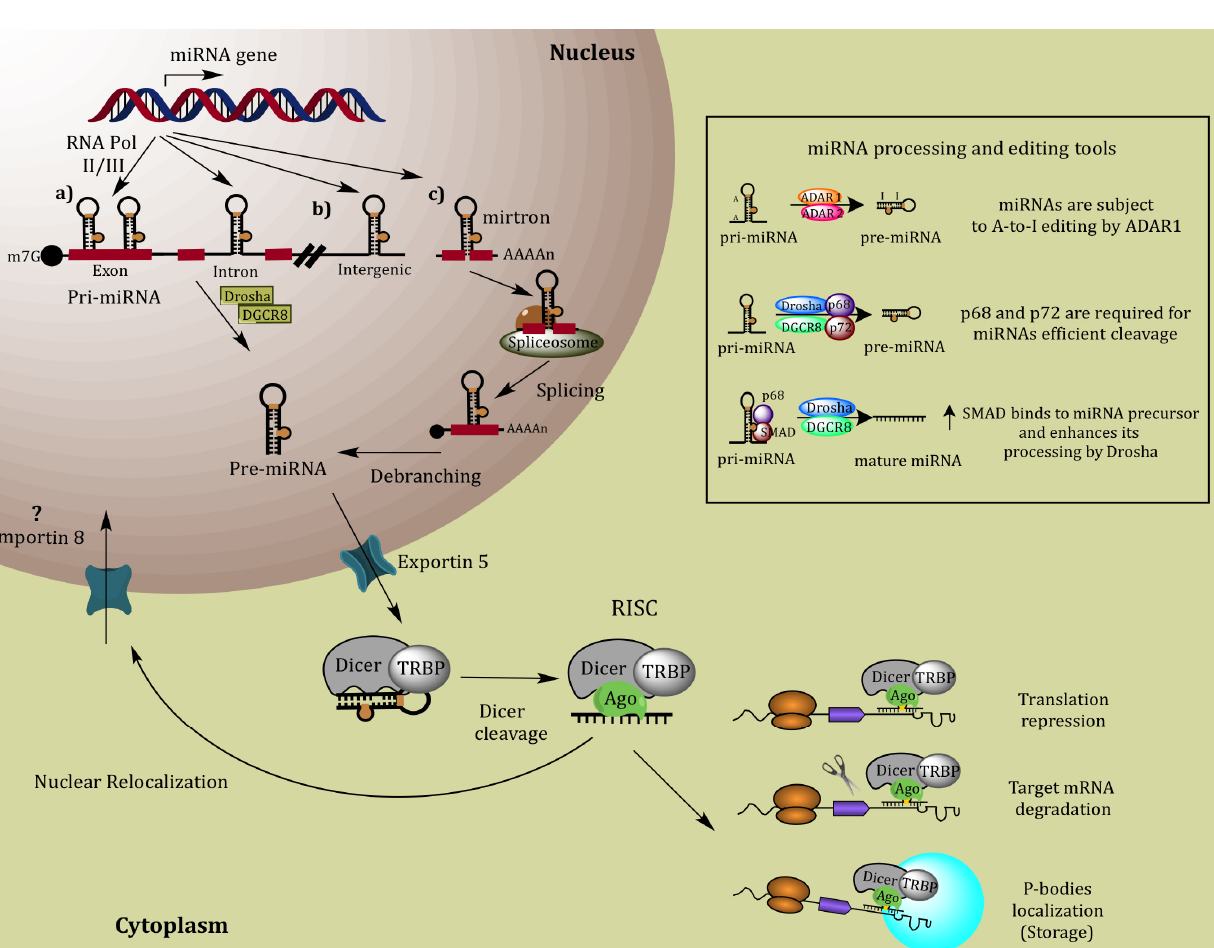
Figure 2. Canonical and non-canonical miRNA biogenesis pathways. RNA pol II transcribes a primary transcript called pri-miRNA which contains a 7-methylguanosine cap and poly(A) tail. Subsequently, this structure is degraded into the nucleus by an RNase type III known as Drosha; producing 70 nt long pre-miRNAs, which are exported to the cytoplasm by exportin-5. Once in the cytoplasm, pre-miRNAs are cleaved by RNase III endonuclease known as Dicer and associated proteins TRBP and PACT, resulting in a double stranded molecule called miRNA duplex. Then, the level of complementarity between miRNAs with their target mRNA could affect the following mechanism: if presented a total complementarity, mRNA degradation is carried out; on the contrary, if complementarity is partial, the inhibition of mRNA translation